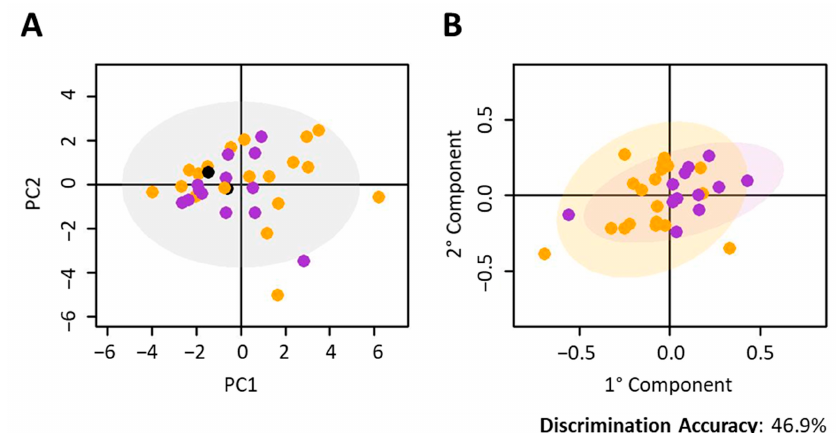
Figure 1. Nivolumab-treated cohort. Discrimination between the metabolomic profiles of baseline serum samples (T0) from di ff erent histology of NSCLC. Score plots of ( A ) PCA analysis of all samples; ( B ) O-PLS analysis of samples with squamous carcinoma and adenocarcinoma. In each score plot, each dot represents a di ff erent serum sample. Orange dots: adenocarcinoma; green dots: squamous cell carcinoma; black dots: NOS